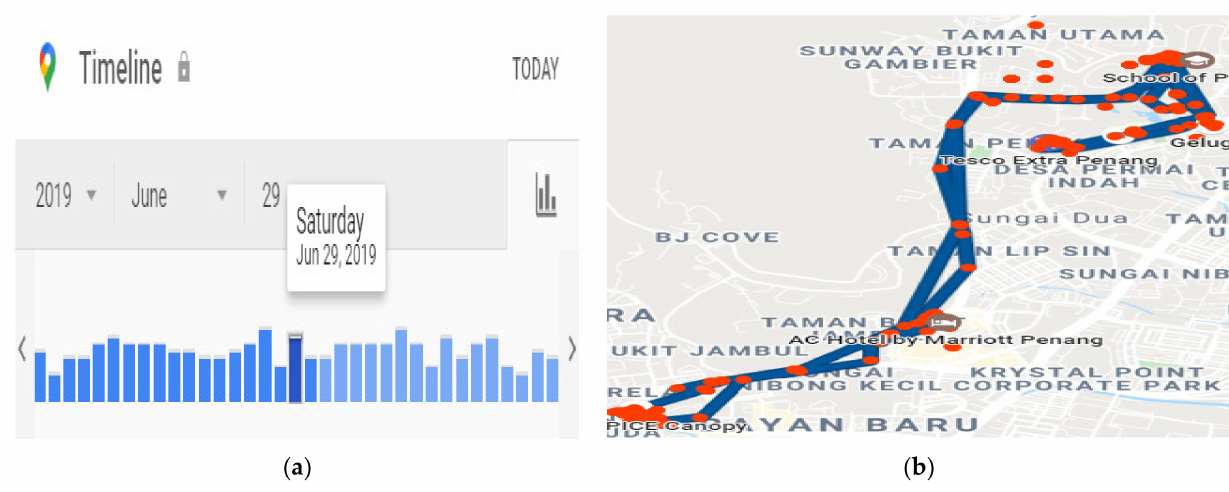
Figure 11. ( a ) Timeline of places visited by subjects. ( b ) Raw geographic